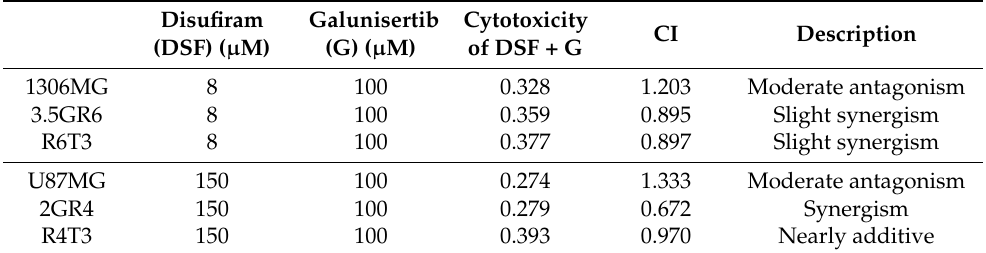
Table 1. The combination index (CI) of combining Disufiram and Galunisertib.